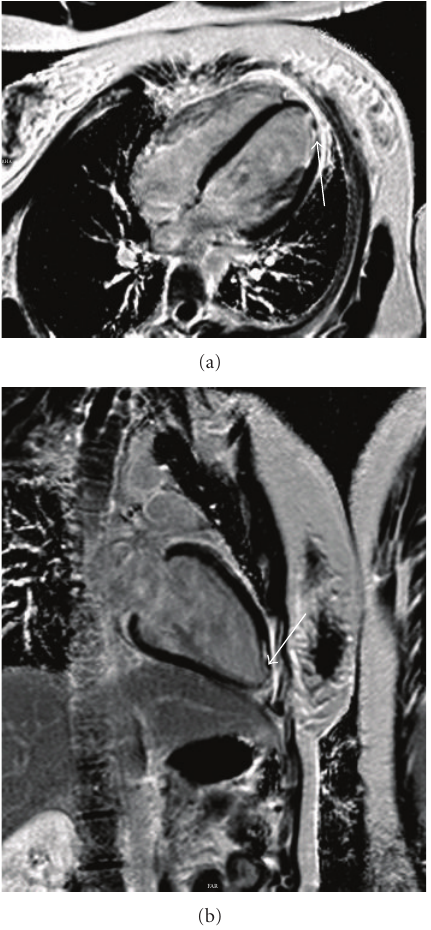
Figure 4: After ablation, a cardiac MRI study was performed. MRI images showed a slightly dilated left ventricle. End diastolic LV volume was 213 mL. End systolic LV volume was 112mL. Stroke volume was 101 mL, LVEF was 47% and IVSDd was